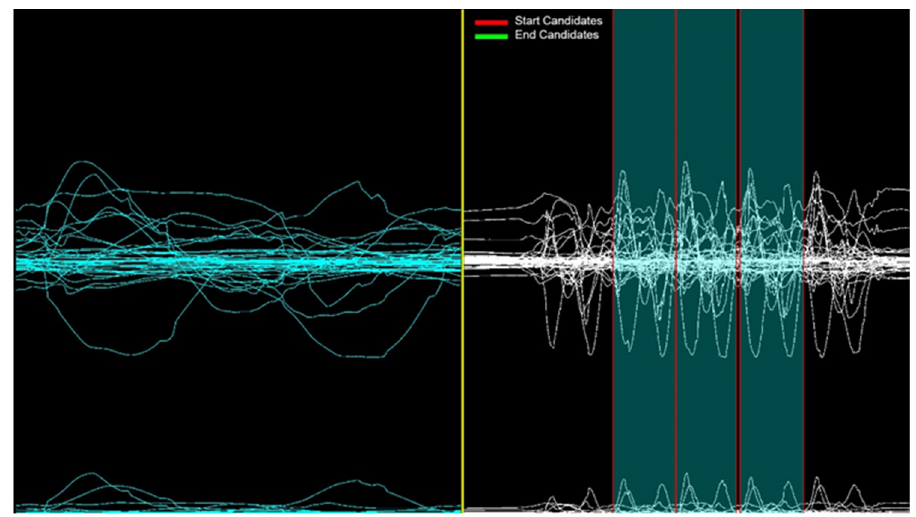
Figure 8. The result with a slice count of 100.